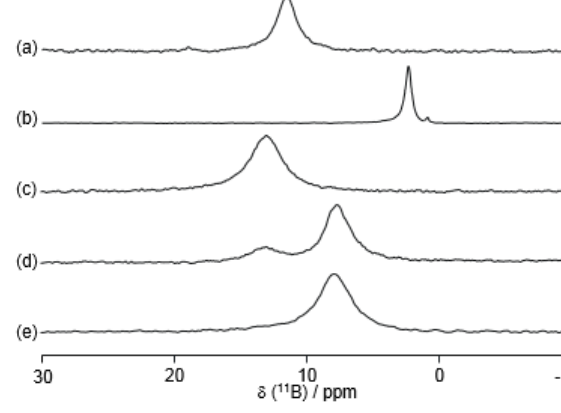
Figure 10. 11 B NMR spectra of 8 (20 mM) under various conditions: ( a ) in D M NaOD·D O solution; ( c – e ) in a mixed solvent (100 mM CHES buffer, 2 pH 10.0/DMSO- d = 3/1, v / v ); ( c ) without D -fructose; ( d ) in the presence of 0.10 M 6 D -fructose; and ( e ) in the presence of 1.0 M D -fructose. The 11 B-frequency (0 ppm) is Et O∙BF in toluene- d . Reprinted with permission from [66]. Copyright 2010 The 2 3 8 Chemical Society of